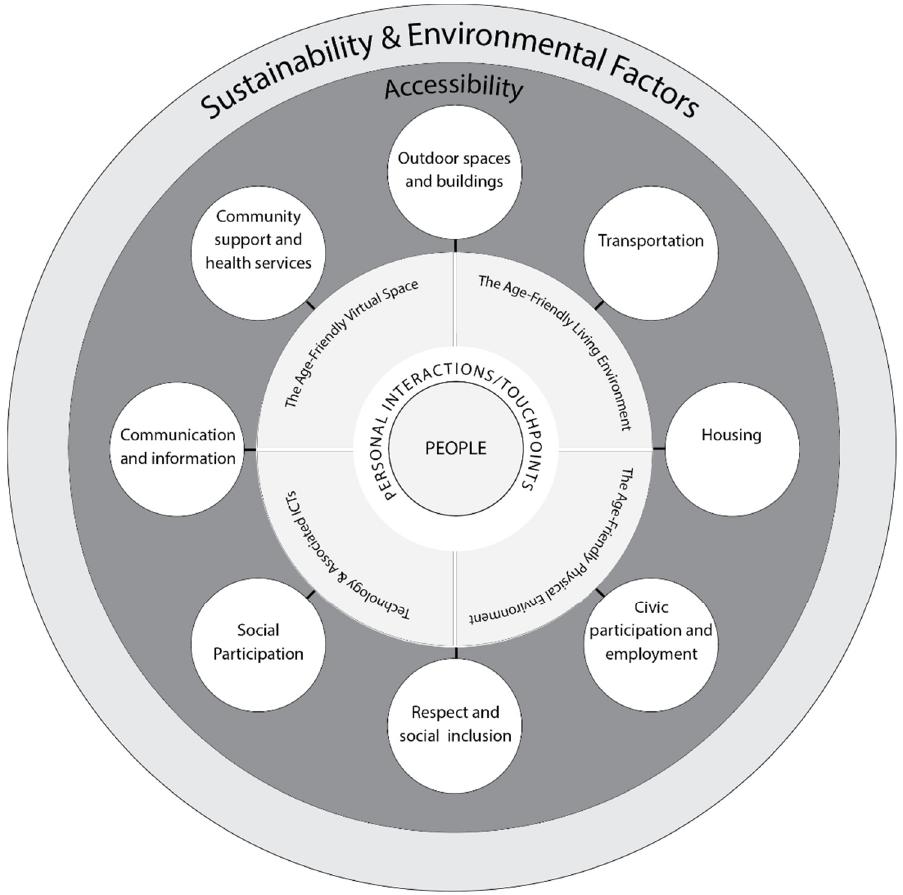
Figure 9. The newly proposed ‘Concept of Age-friendly Smart Ecologies (CASE)’ framework. Th